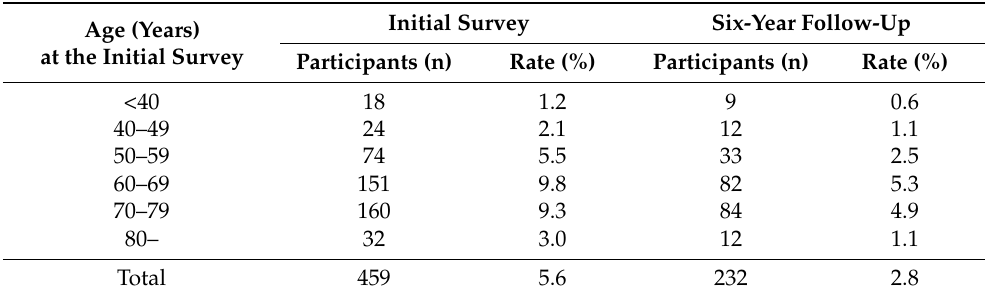
Table 1. Proportion of participants at the initial survey and six-year follow-up. Age (Years) at the Initial